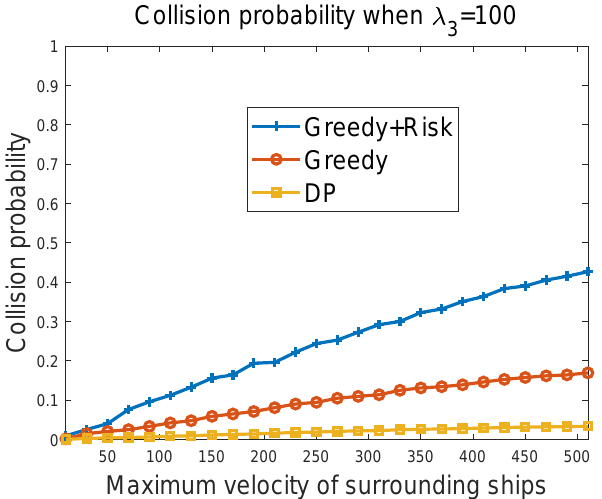
Figure 10. Collision probability vs. maximum velocity of other ships when λ 3 = 10.